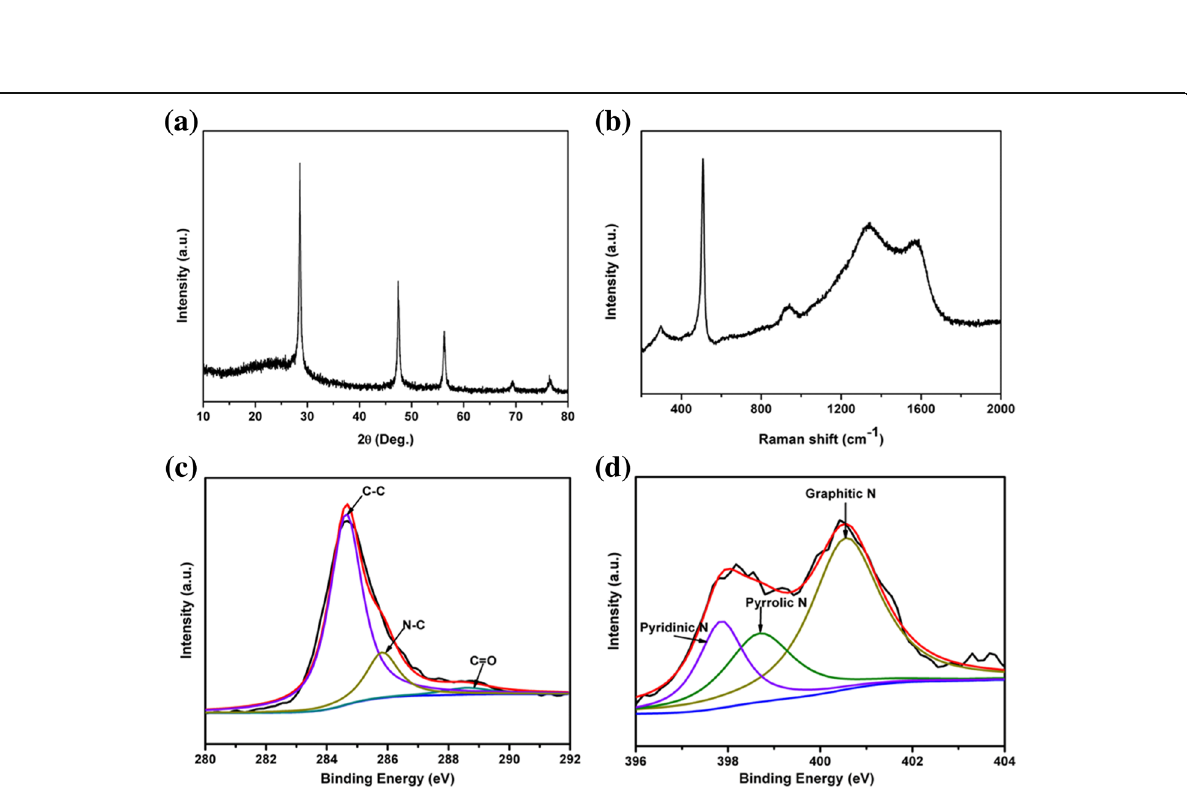
Fig. 3 a PXRD patterns, b Raman spectra, c high-resolution C 1 s XPS spectra, and d high-resolution N 1 s XPS spectra of pSi@NC composite